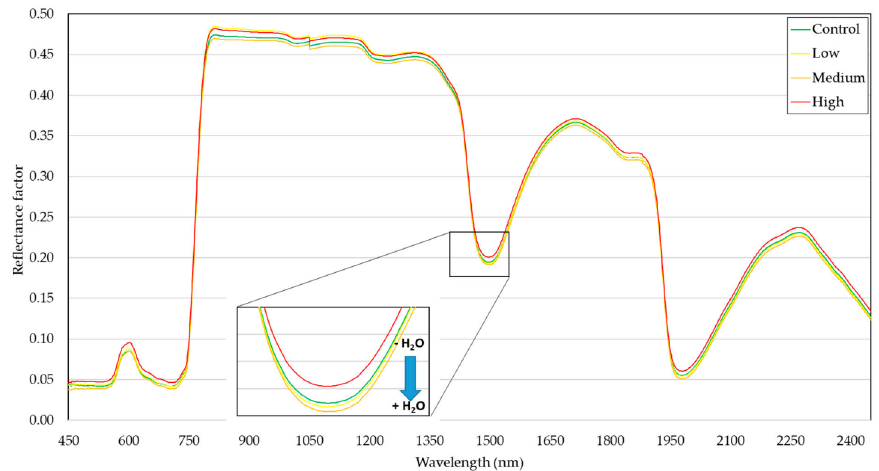
Figure 3. Average spectral curves (450–2400 nm) of soybean leaves under different levels of whitefly